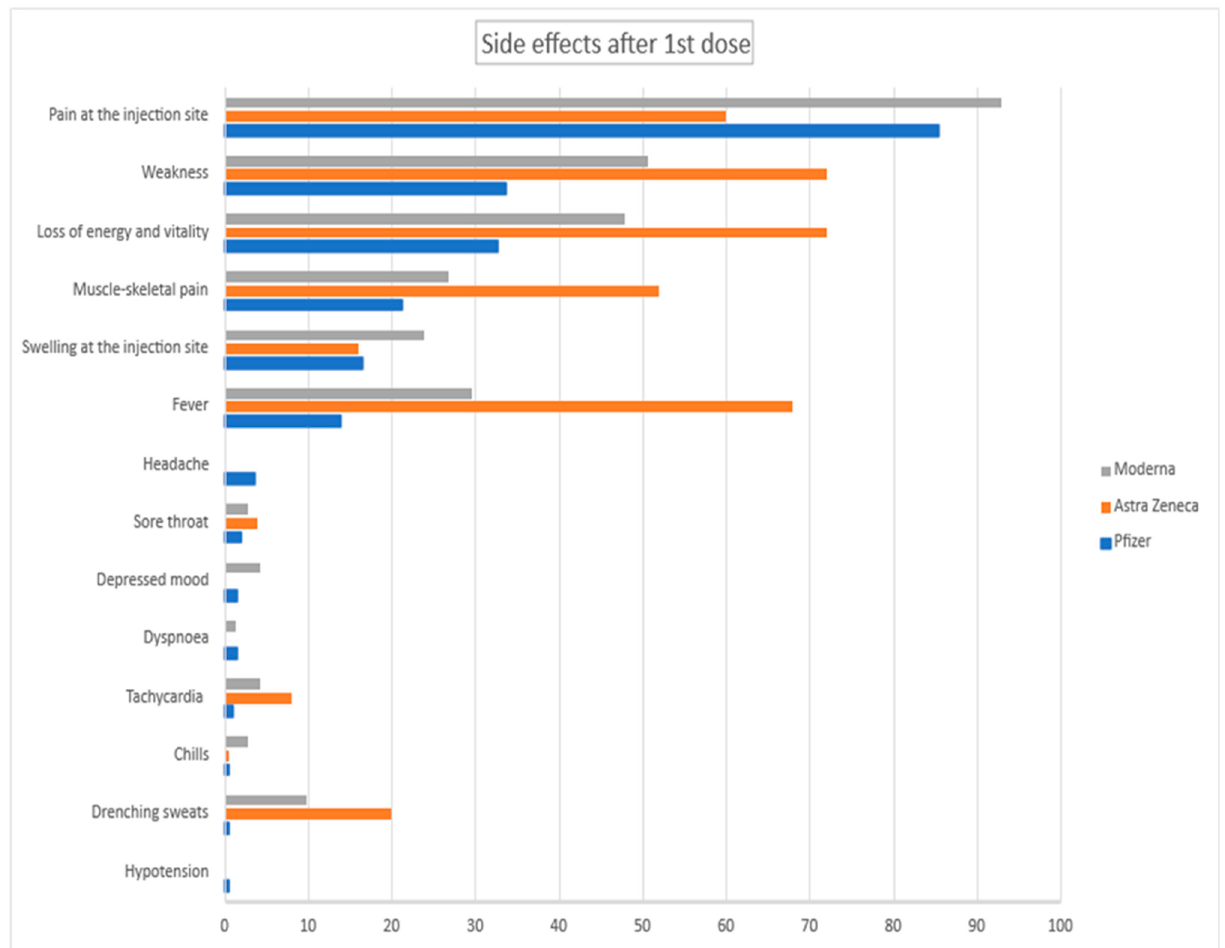
Figure 4. Side effects after 1st dose for specific vaccines in %.